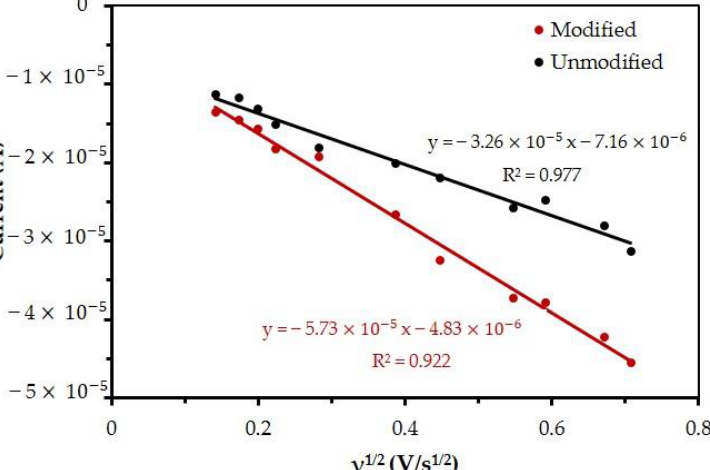
Figure 7. Measurement of oxidation peak current, for unmodified and modified electrodes, as a function of the applied scan rate. The measurements were obtained using a solution of 5 mM K 3 [Fe(CN) 6 ] and 0.1 M KCl. This graph was used for the calculation of the total active area.